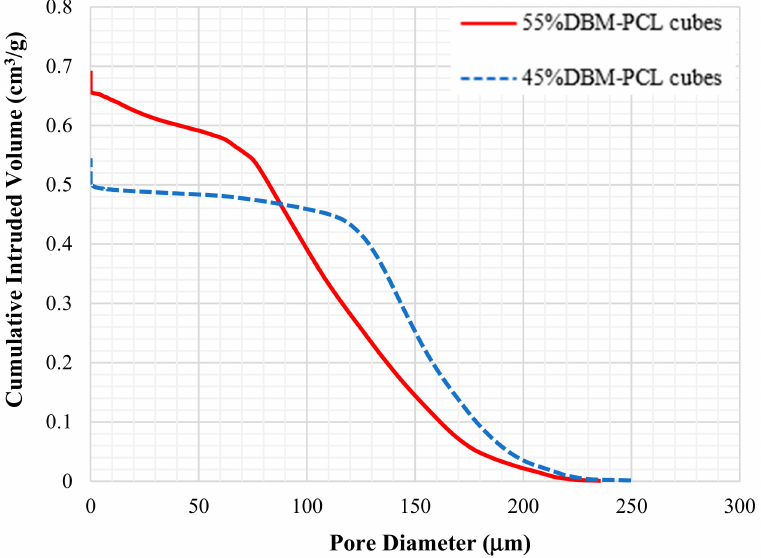
Figure 14. The intrudable porosity of DBM / PCL hybrid sca ff olds measured by the MIP